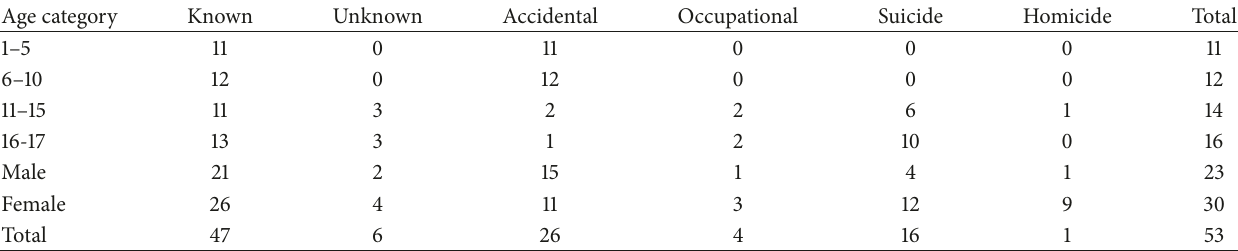
Table 1: Age category and circumstances of poisoning for APP amongst children in